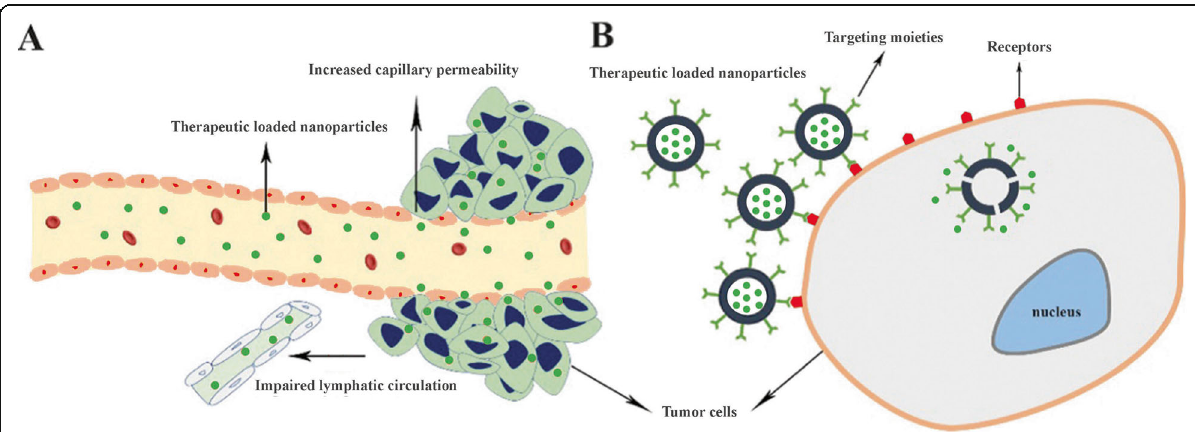
Fig. 1 Targeting mechanisms of nanocarriers against cancer. a Passive targeting where NCs accumulated in tumors as a result of leaky blood vessels and impaired lymphatic drainage in tumor tissues (EPR effect). b Active targeting wherein NCs surface decorated with ligands interact with cancer cells and internalized via receptor-mediated endocytosis mechanism